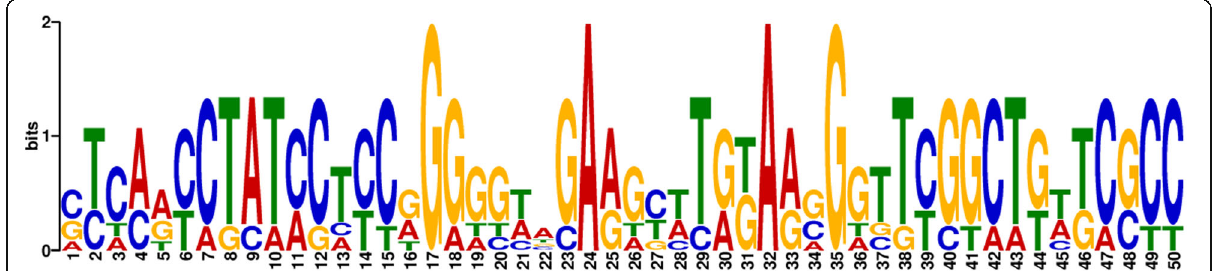
Fig. 2 Sequence logos for identified common promoter motif, motif IV of Trametes hirsuta strain 072 using MEME